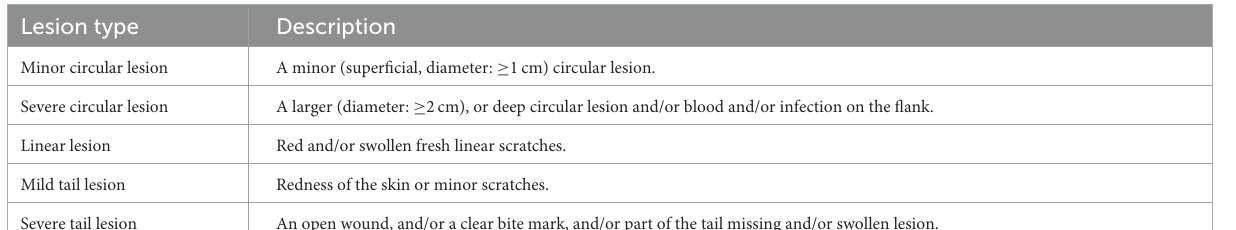
TABLE 1 Scoring system for the circular, linear, and tail lesions in pigs [adapted from (12)]. Lesion type Description Minor circular lesion Severe circular